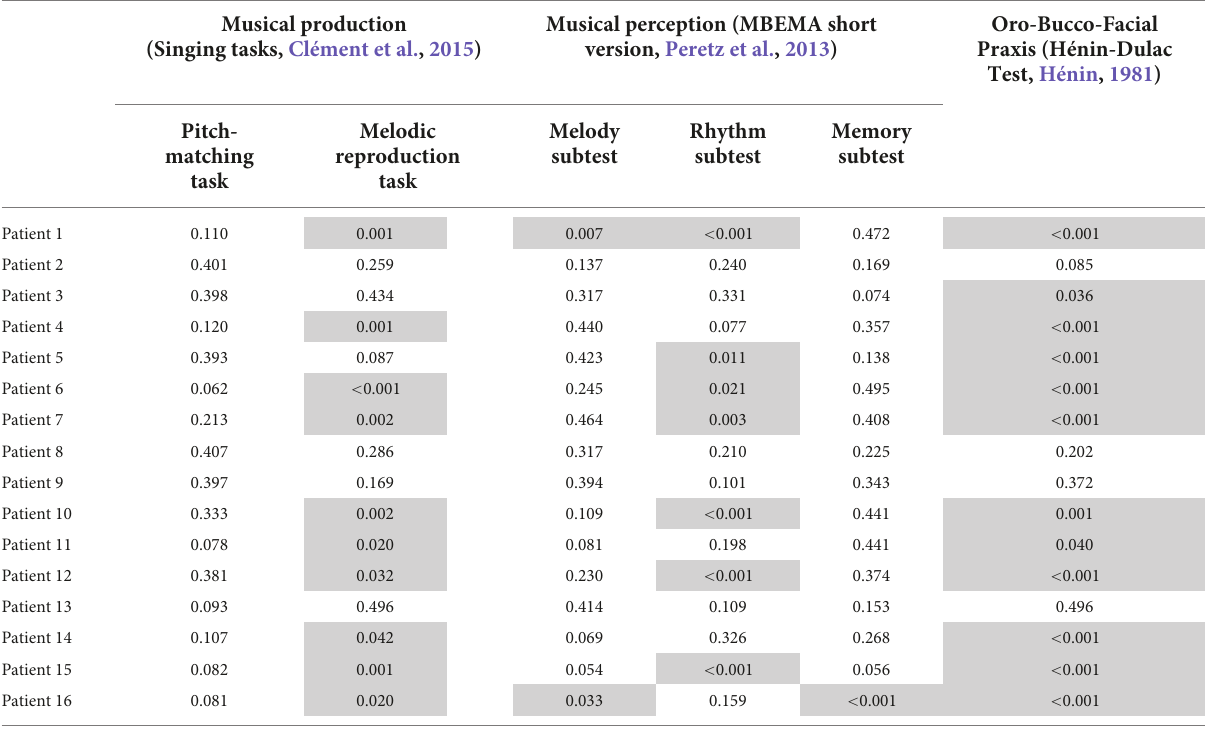
TABLE 3 Summary of the individual analyses results for each task. P -Values at the Bayesian test of deficit Musical production Musical perception (MBEMA short (Singing tasks, Clément et al., 2015) version, Peretz et al., 2013)